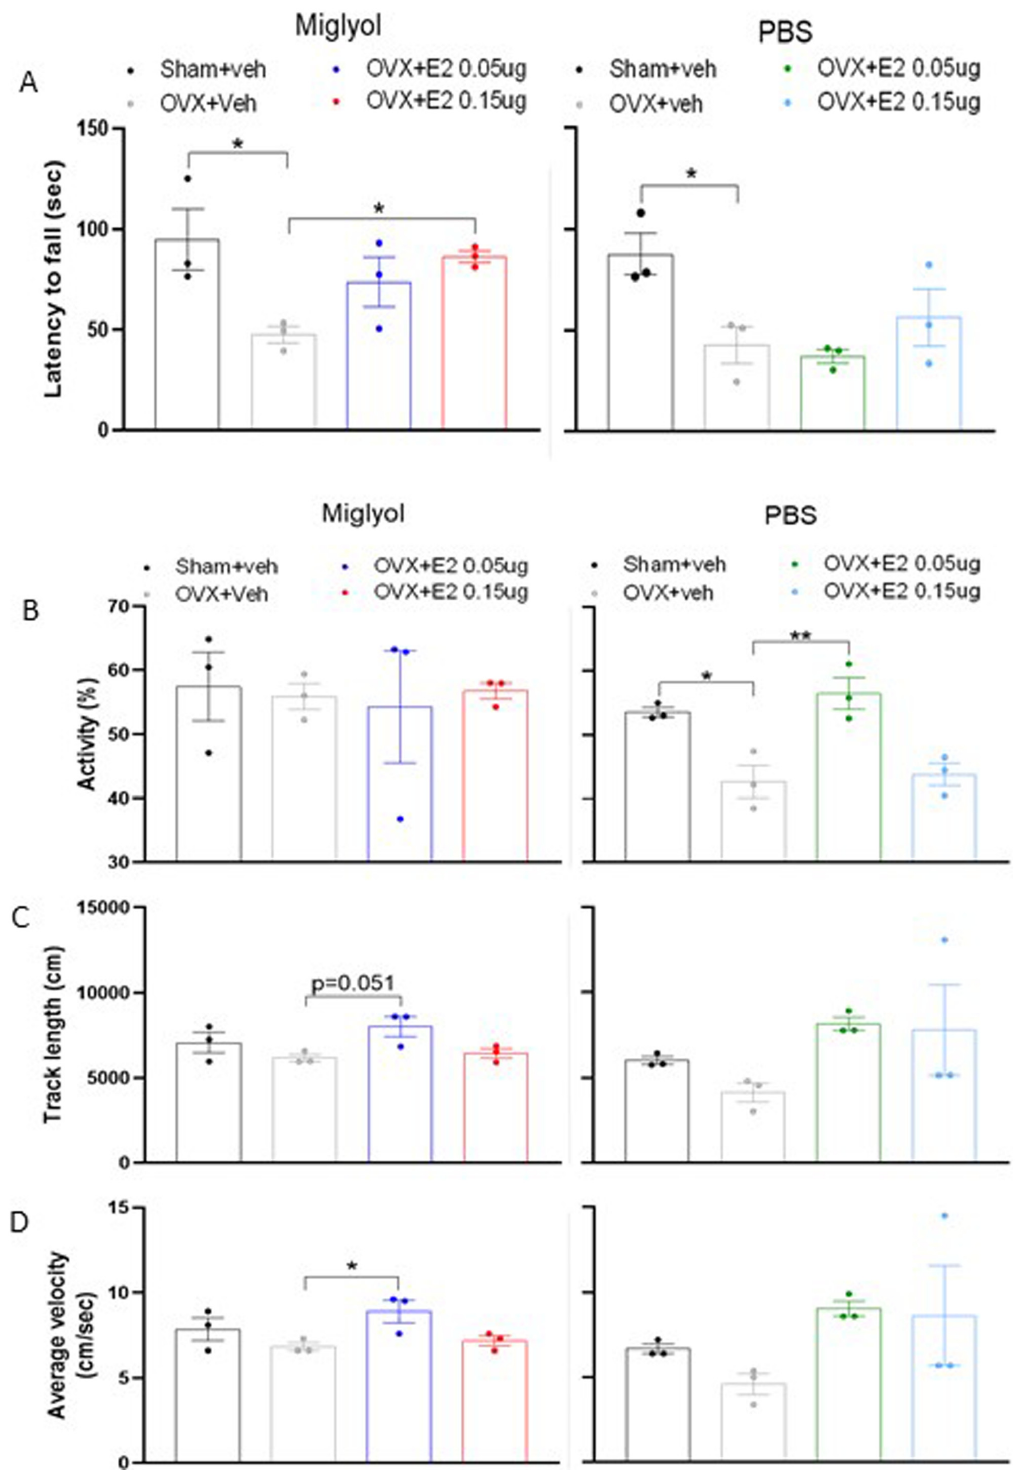
Figure 8. Motor ability determined by rotarod and open field tests after 8 weeks of treatments. Mice were subjected to Sham or OVX surgery and treated with s.c. injections of vehicle (miglyol or PBS) or 17β-estradiol (E2; 0.05 µg/mouse or 0.15 µg/mouse) every 4 days. After 8 weeks of treatments, motor behavior was tested using the rotarod test for measurement of latency to fall ( A ) and the open field test to measure activity ( B ), track length ( C ) and average velocity ( D ). Data are expressed as mean±SEM; n=3 for each experimental group. One-way ANOVA followed by Dunnet’s post-hoc test was used to analyze differences between sham+veh vs OVX+veh; or OVX+veh vs the E2 treatment groups. *, p<0.05; **, p<0.01.